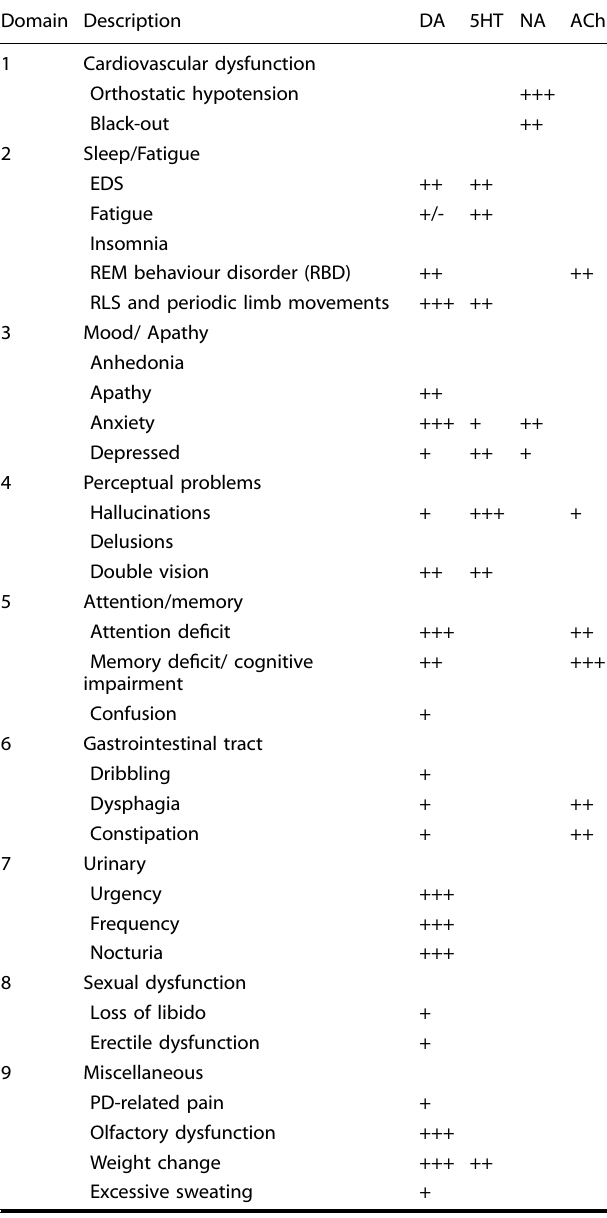
Table 10. Neurotransmitters involvement in the NMS of PD